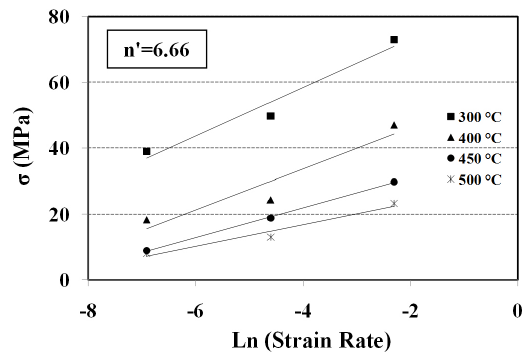
Figure 2. Relation between ln ( σ ) and ln ( ε  ) of rolled AZ31 experimental alloy.